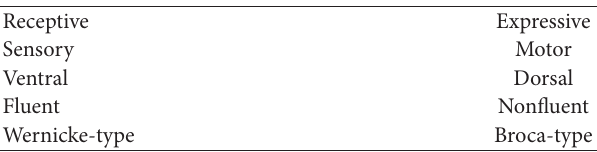
Table 1: Different names used to refer to the two basic aphasic